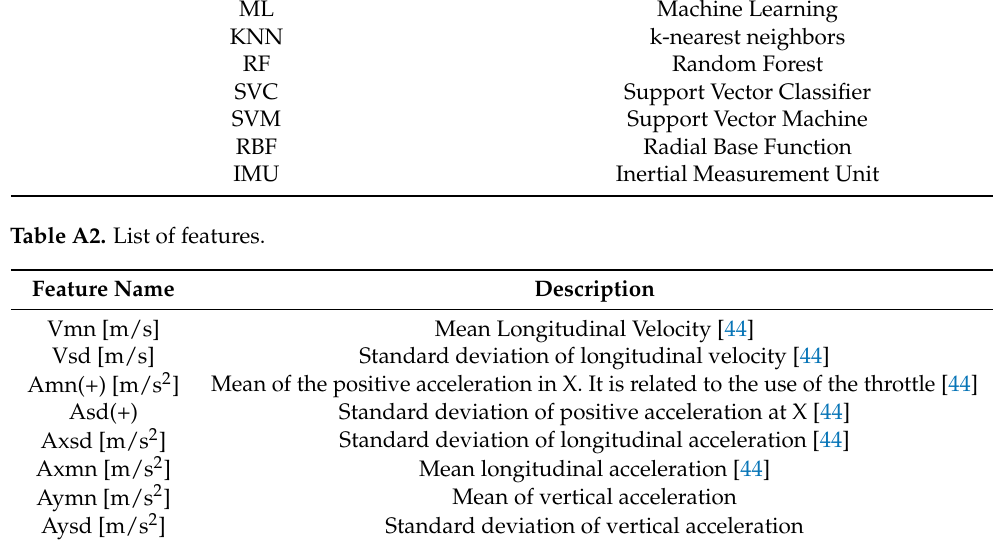
Table A1. List of acronyms.